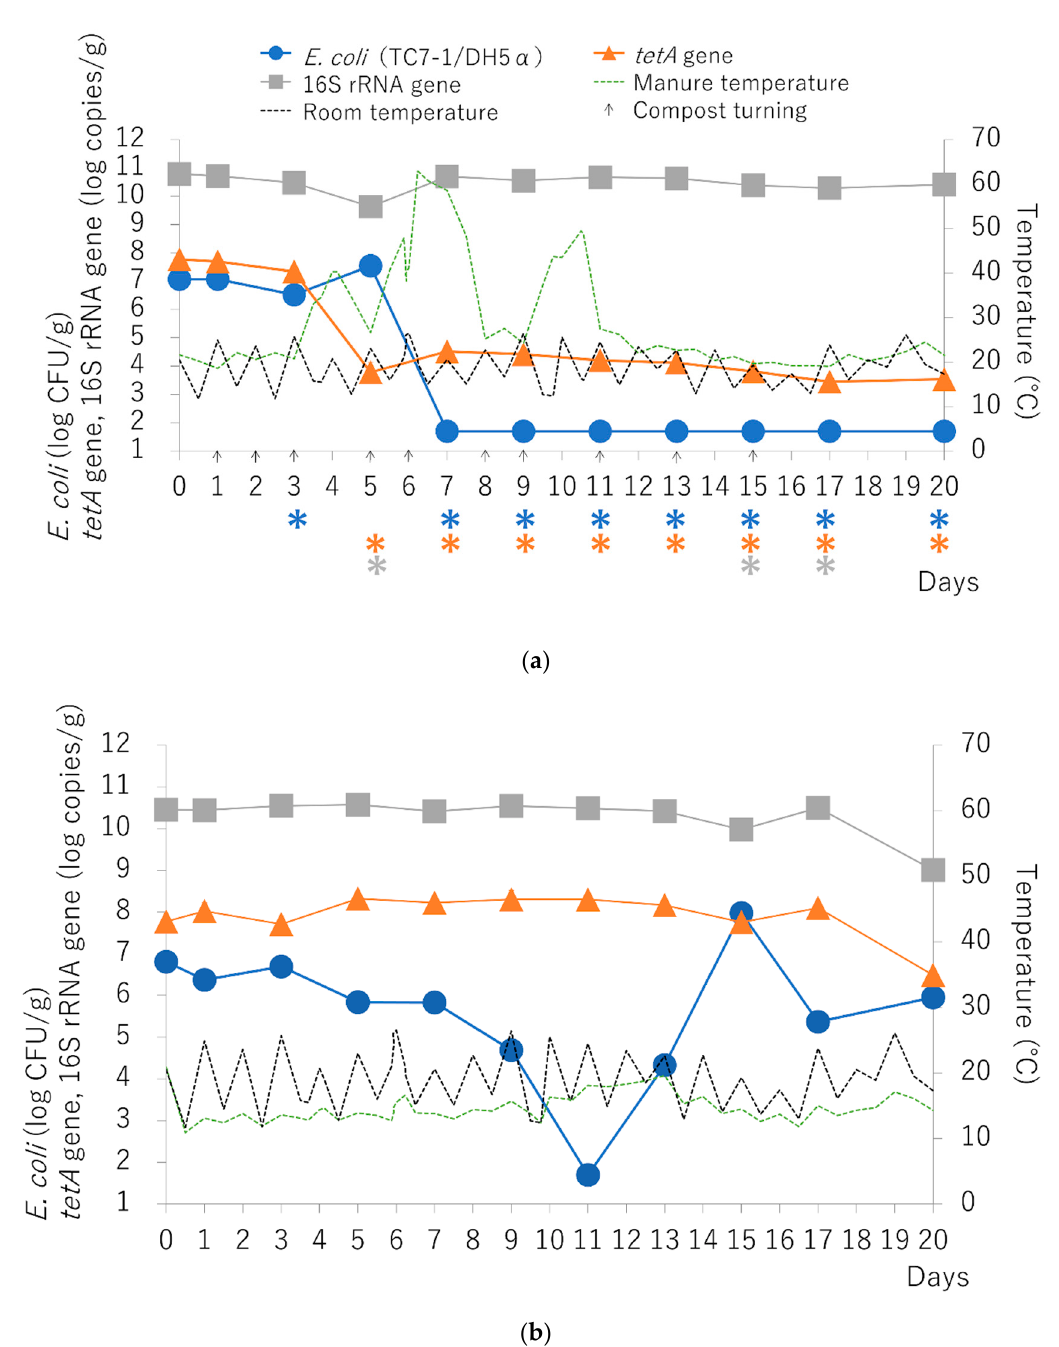
Figure 2. Variation in E. coli , tetA gene, and 16S rRNA gene amounts during simulated composting ( a ) and control ( b ) with pig manure. Bars represent standard errors. Asterisks (*) under the number of days represent the day of significant difference compared to day 0 ( p < 0.05). The detection limits are 50 CFU/g ( E. coli ), 2.92 log copies/g ( tetA gene), and 3.53 log copies/g (16S rRNA).